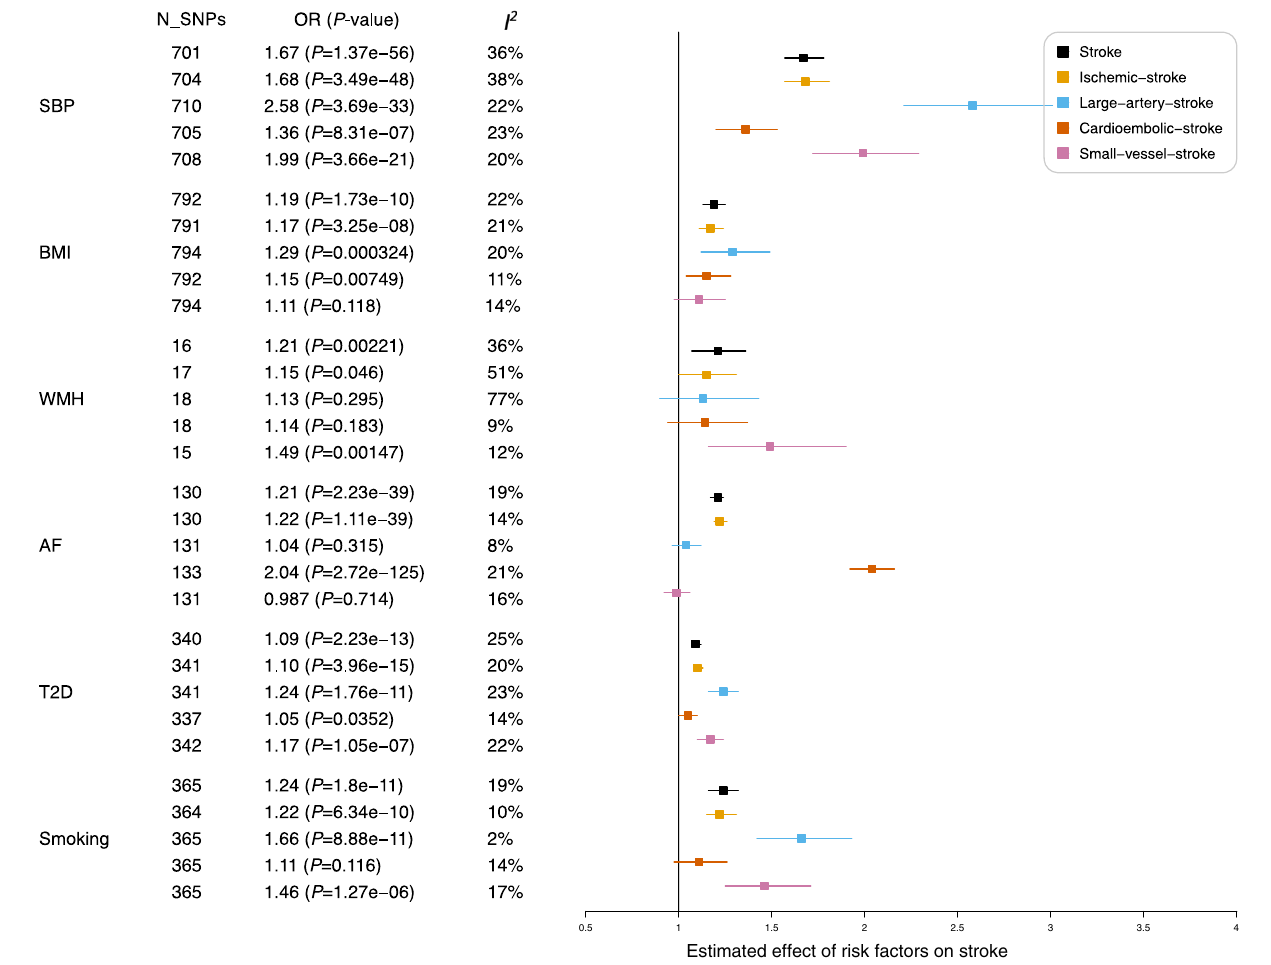
Fig. 4 | Causal effects of risk factors on stroke outcomes. MR analyses of the effect of risk factors on stroke outcomes. The squares are the causal estimates on the OR scale, and the whiskers represent the 95% con fi dence intervals for these ORs. N_SNPs number of SNPs used for the estimation of the causal effects in this